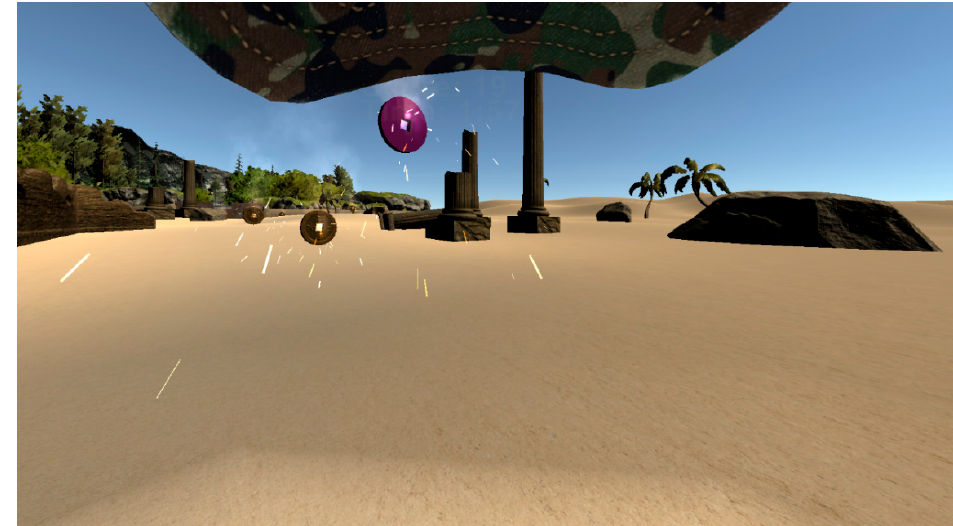
Figure 2. The ancient desert scene in the high action (HA) game with a baseball hat as a head-centric rest-frame. In the front, there is a visible violet coin. For collecting it, the player needed to jump.